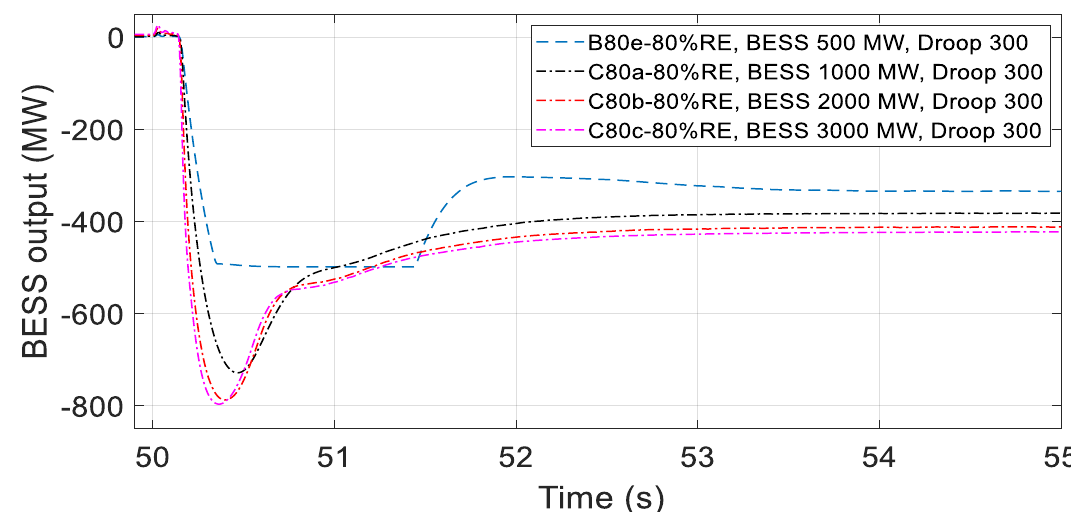
Figure 11. BESS output power with a variation in BESS capacities.